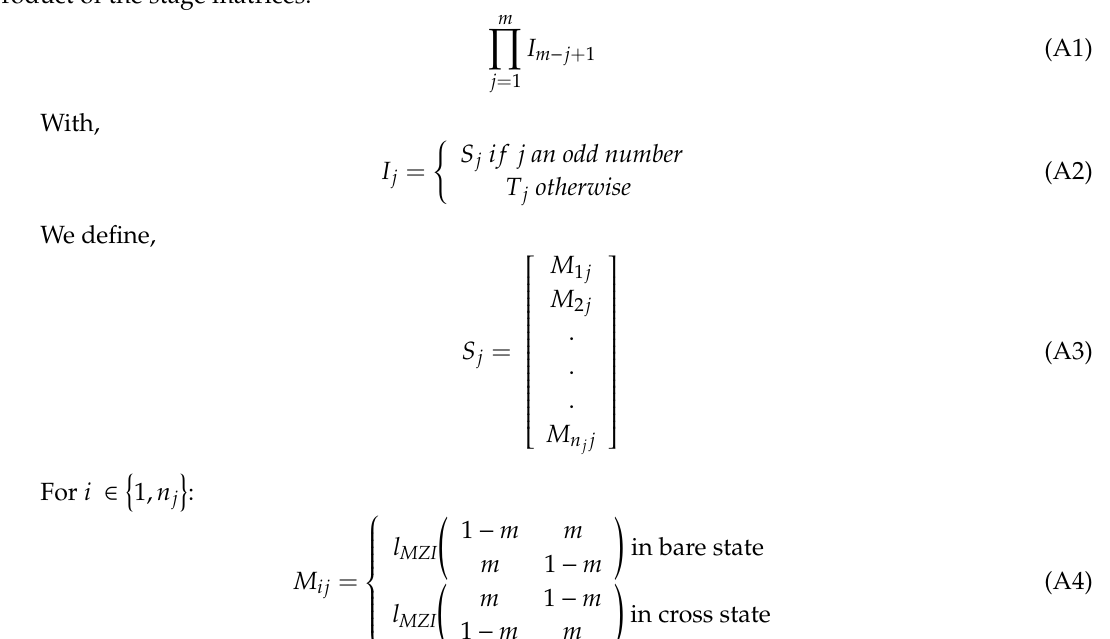
stages, S j − 1 and S j + 1 .